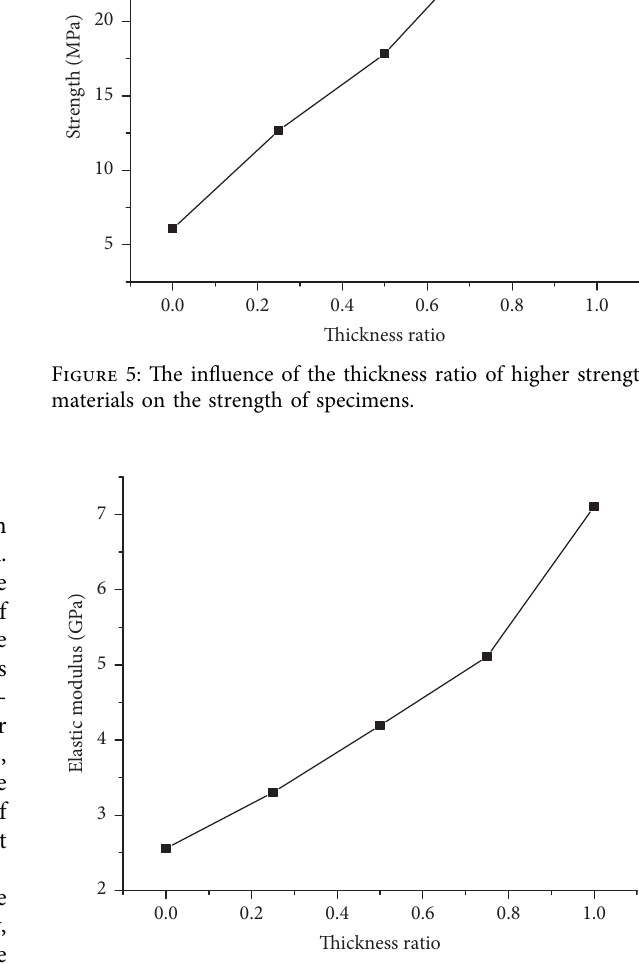
Figure 6: Effect of volume fraction of high-strength materials on the elastic modulus of